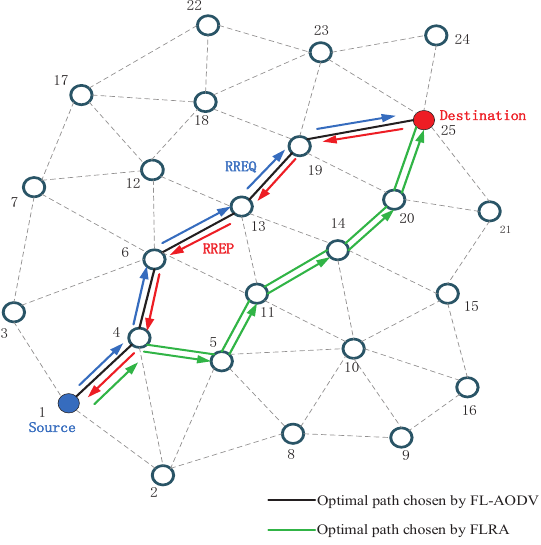
Figure 1. System model of establishing and evaluating the fuzzy-logic-assisted AODV routing